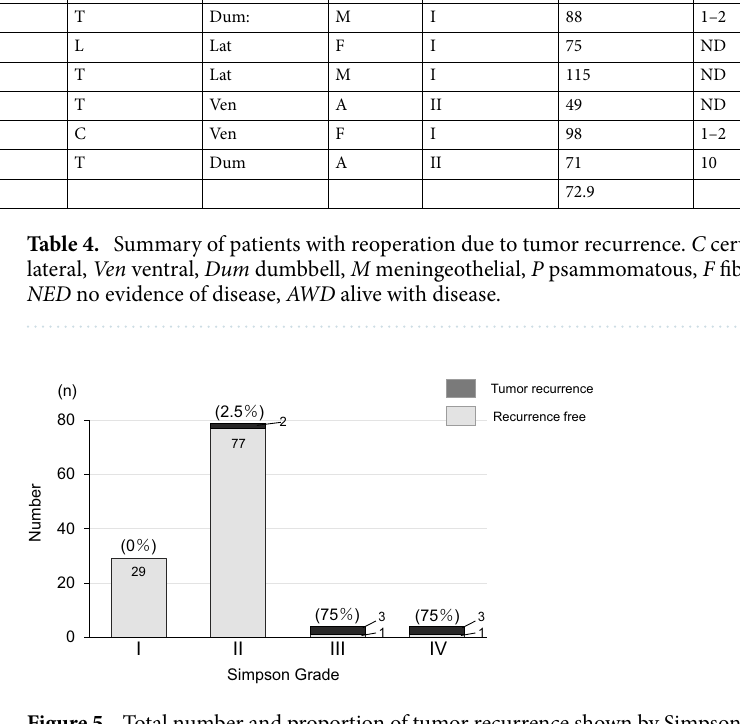
Figure 5. Total number and proportion of tumor recurrence shown by Simpson